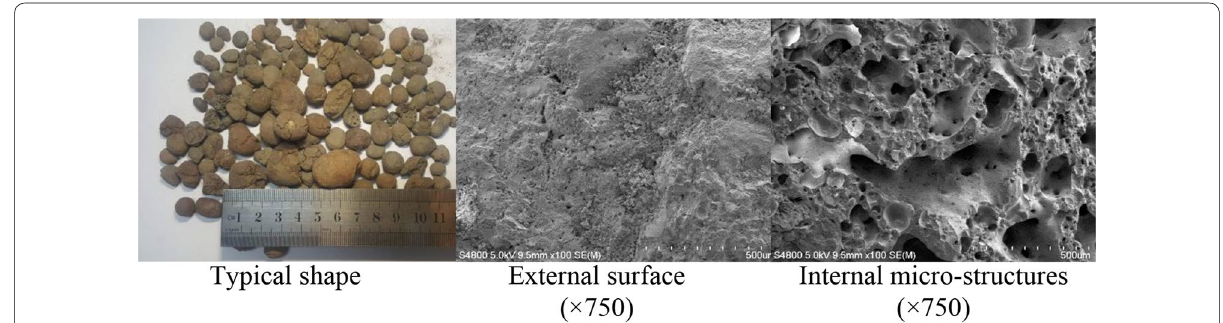
Fig. 2 Shape and scanning electron microscopy (SEM) images of the lightweight coarse aggregate used.